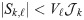
The SB for the SI S
k, ℓ, see Eq (4), can be written as |Sk,ℓ|<VℓJk, where Vℓ=Var(Fℓ) and Jk=Ikk(Q[0,T]θ).In this figure, the x-axis is divided into K = 7 intervals each with size Jk and the y-axis into 3 intervals each having size V
ℓ. The model is the p53 and the observables chosen here is the maximum amplitude of the PSD (Eq (19)) for the 3 species. The area of the (k, ℓ) rectangle corresponds to the SB of S
k, ℓ. The red, green, blue and orange rectangles correspond to values of the SB larger than 5000, between 5000 and 500, between 500 and 50 and less than 50, containing 10, 5, 0, and 6 SIs, respectively. Notice that the 6-th and 7-th parameters are relatively insensitive since the corresponding pathwise FIM elements are relatively very small.